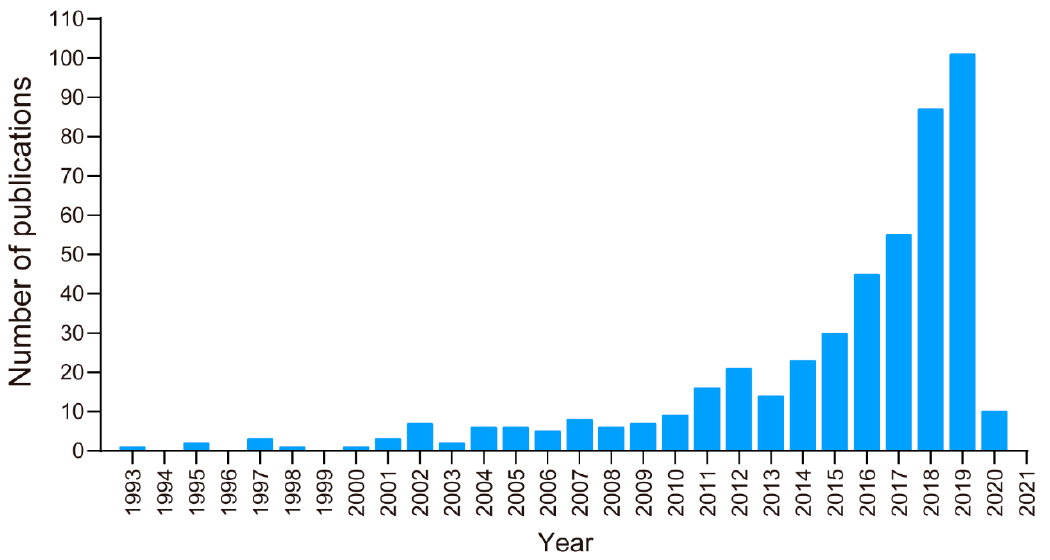
Figure 1. The number of journal publications with “environmental DNA (eDNA), eutrophication and harmful algae bloom/s (HAB/s)” in title, abstract and keywords during 1975–2020 (2nd March) in Web of Science. The data in the present work were sourced from the online database of the Science Citation Index Expanded (SCIE), Web of Science. This database is the most comprehensive and frequently used data source in bibliometrics [35,39]. The exact query was TS = ((“environmental DNA” OR “environment DNA” OR “eDNA”) AND (“eutrophication” OR “eutrophic” OR “nutrient*” OR “nitrogen” OR “phosphorus” OR “phosphate” OR “bloom” OR “blooms” OR “harmful algae bloom*” OR “HAB*”)), and the timespan was from 1975 to 2020 (2nd March).